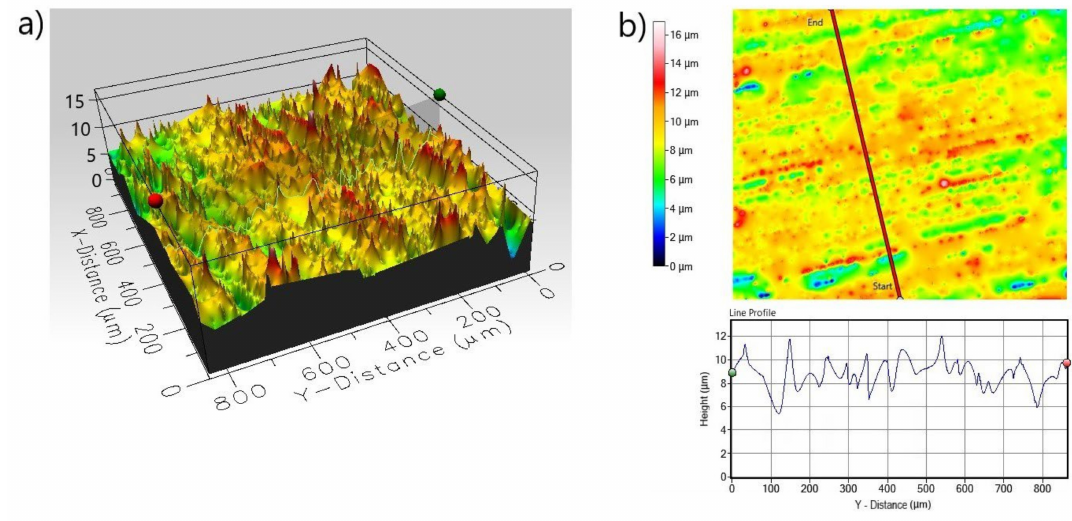
Figure 12. 3D profile ( a ) and 2D profile ( b ) of the corroded surface of borided Inconel ® 600 alloy after the corrosion resistance test in a 3.5% NaCl solution.